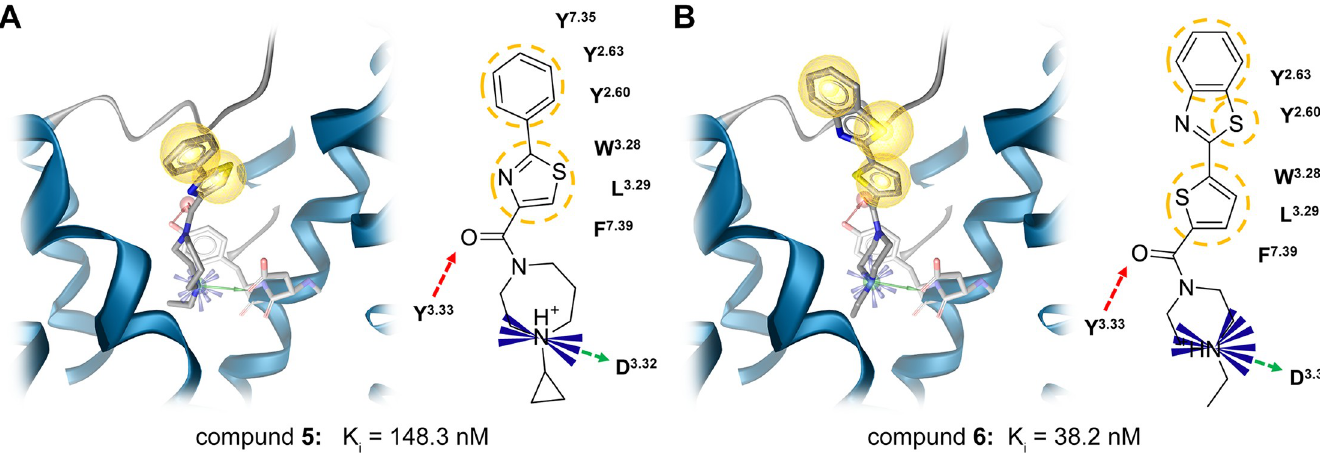
Fig 5. Potential binding modes of active ligands are very similar. Observed interaction of screening hits 5 (A) and 6 (B). Red arrows–hydrogen bond acceptors, green arrows–hydrogen bond donors, blue star–positive ionizable, yellow sphere–hydrophobic contact.